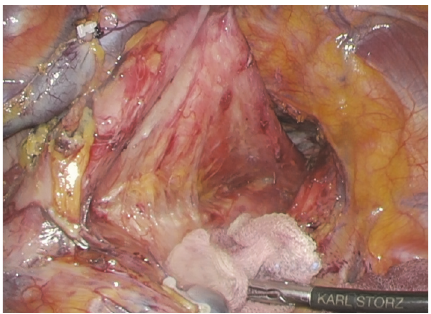
Figure 3: Intraoperative findings showed dilated esophagus. We secured the surgical field by elevating the esophagus dorsally and pushing down the trachea